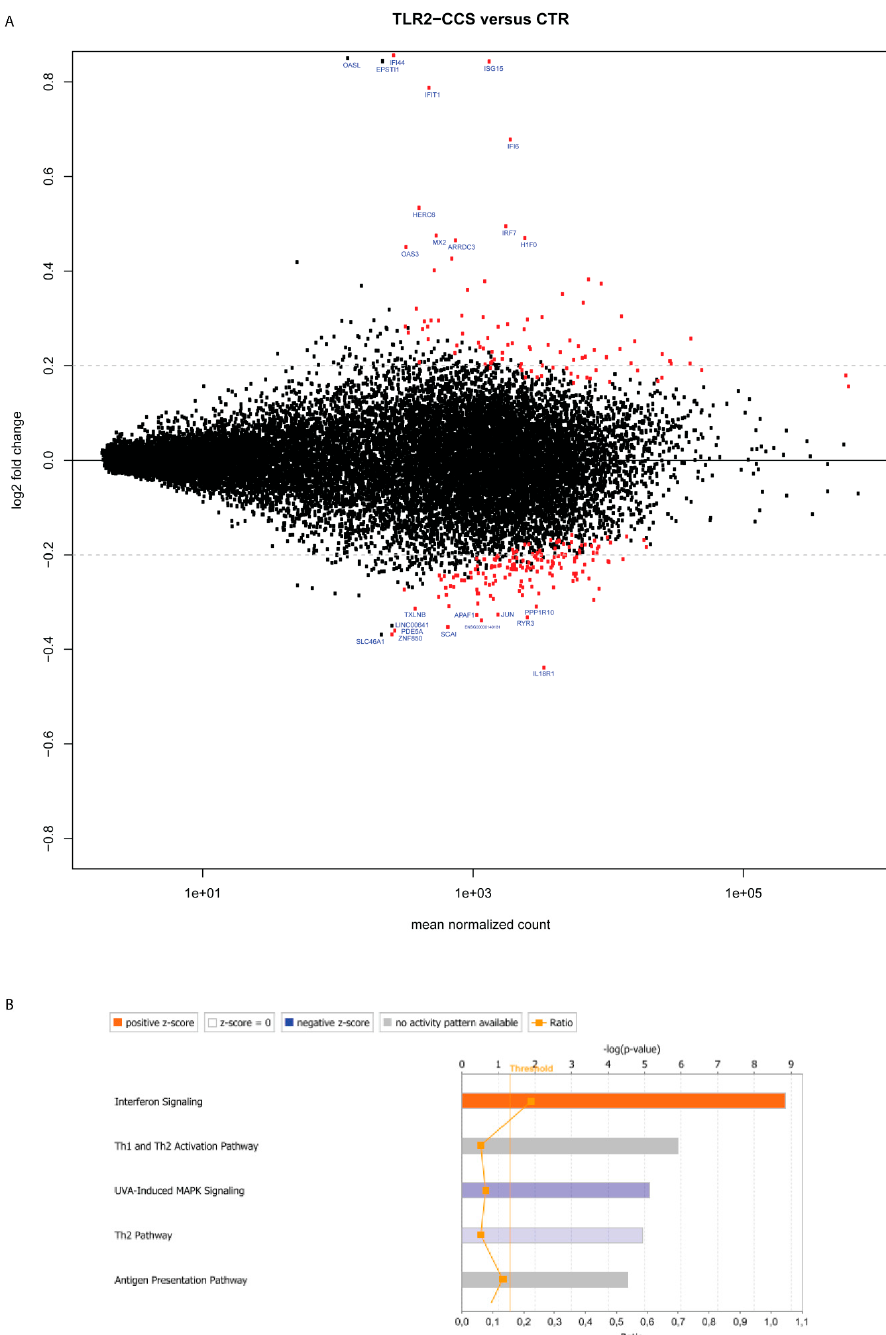
Figure 2. Deregulated genes in TLR2-primed MCs cocultured with HT29 spheroids. ( A ) Plots of normalized mean count (gene expression) versus log 2 -transformed gene expression fold change (log 2 FC) for TLR2-primed MCs cocultured with HT29 spheroids (TLR2-CCS) versus control MCs (CTR). Each dot represents a transcript. Dots in red were significantly differentially up- or downregulated ( p < 0.05) ( n = 2). Dots labeled with the gene symbol were the top 10 upregulated or downregulated genes. The p values were computed by the Wald test and were corrected by the Benjamini-Hochberg procedure. The black horizontal line denotes the base line level and the grey horizontal line denotes the value of log 2 FC = 0.2. ( B ) The top 5 canonical pathways enriched in TLR2-CCS. Pathways in red indicate activated and in blue suppressed. Pathways in grey indicate no functional prediction available. The vertical line denotes the significance level of α = 0.05. (- (cid:3) -) The ratio represents the number of genes from the dataset that are part of this